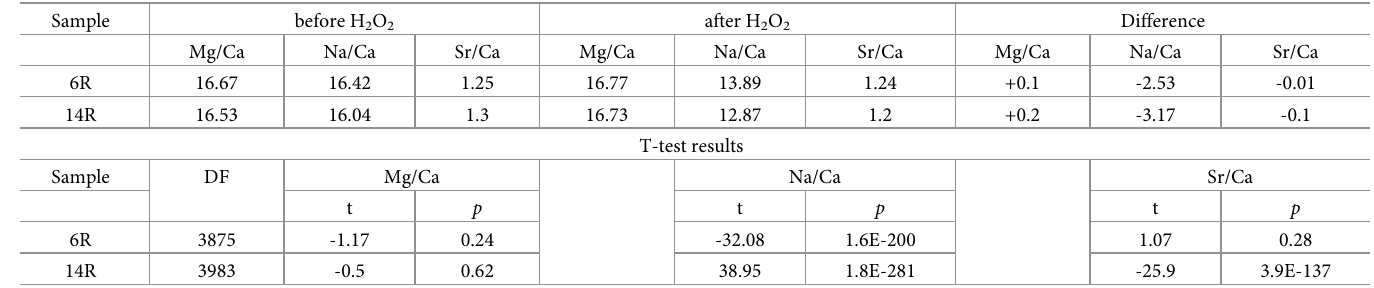
Table 2. Mean E/Ca ratios (mmol/mol) and differences before and after H 2 O 2 treatment. Sample